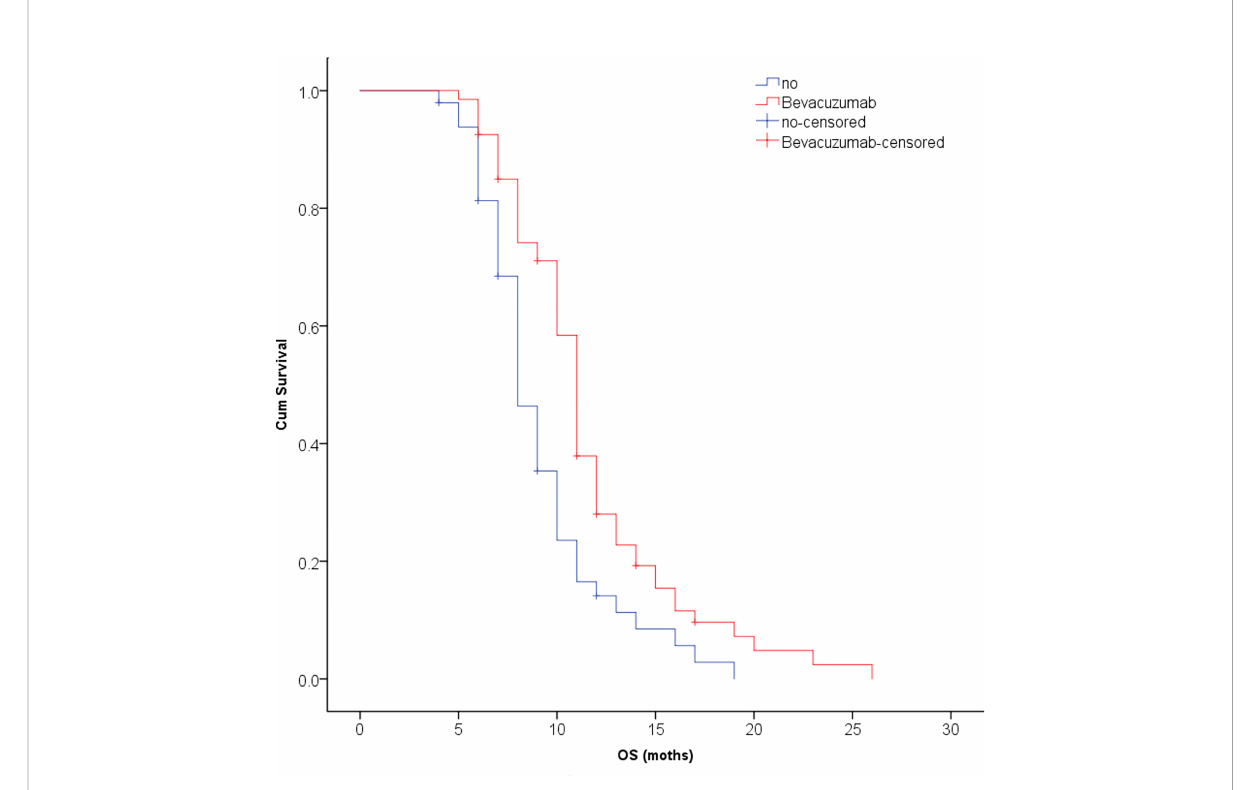
FIGURE 3 The multivariate analysis showed that bevacizumab could signi fi cantly improve the survival time of patients with CRC brain metastases (P =